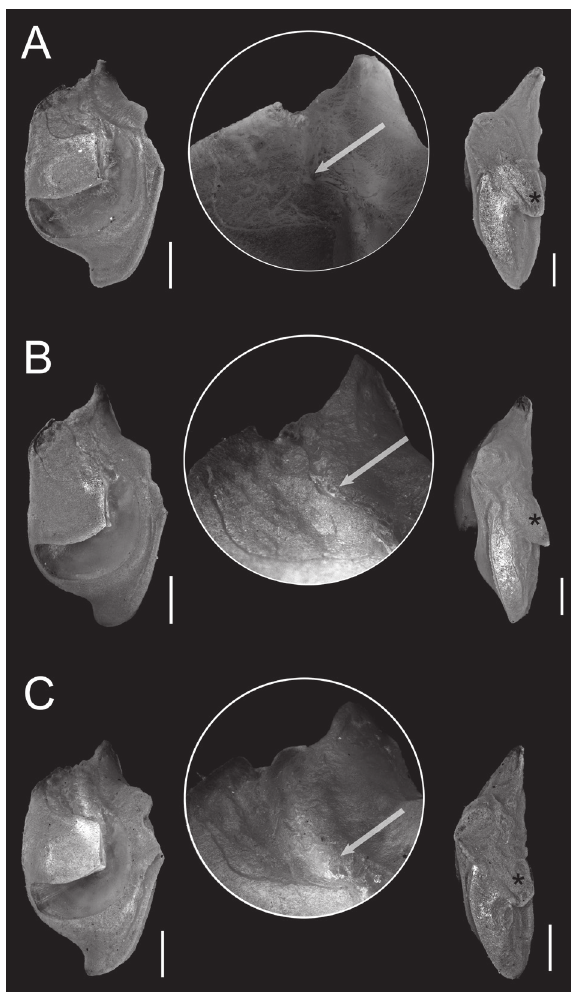
Left: inner face; Middle: inset of the ostium ; Right: dorsal profile. Arrow indicates spout-like groove; asterisk indicates projection on the outer face. Scale bars = 1